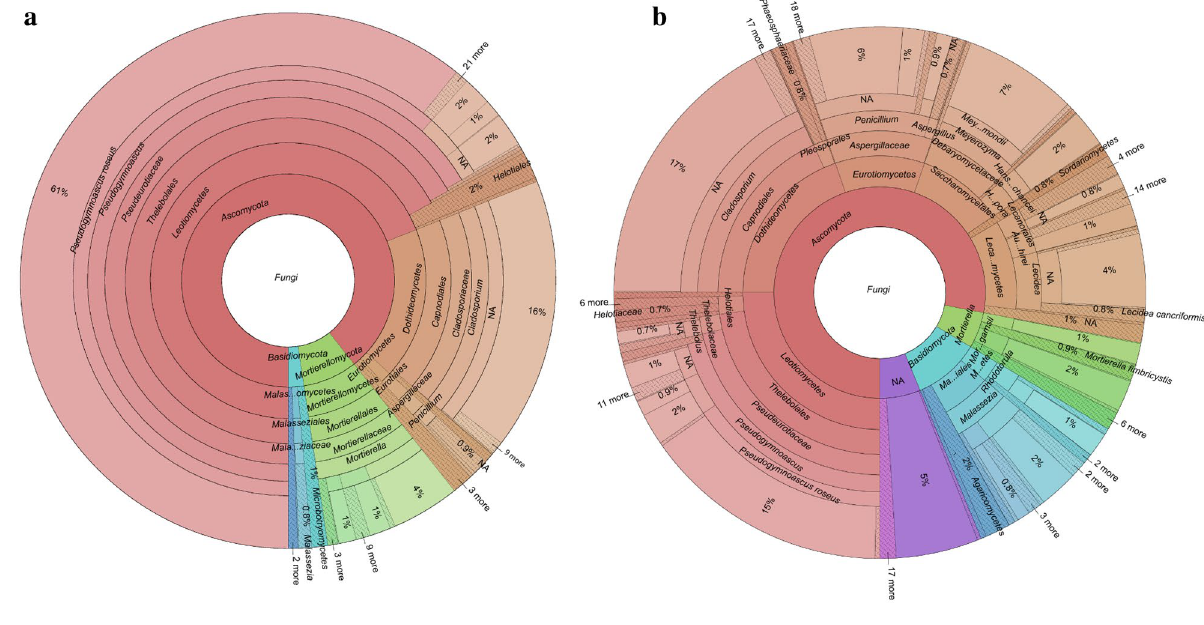
Figure 2. Krona chart of ( a ) fungal assemblages detected in the air and ( b ) in snow from Livingston Island, South Shetland Islands, Antarctica.